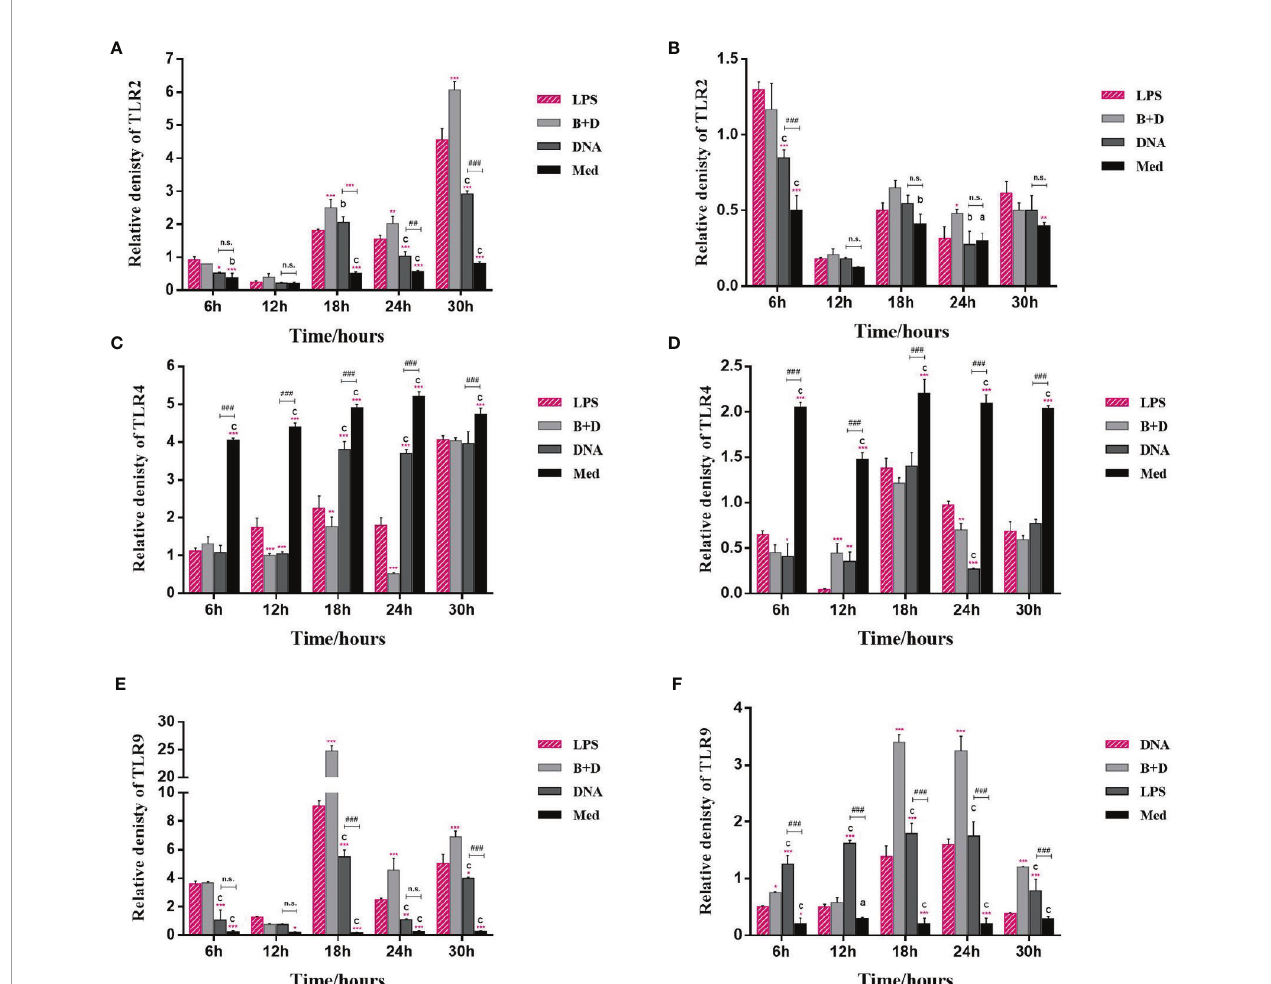
FIGURE 4 | mRNA expression of TLRs in macrophages. RAW264.7 cells and peritoneal macrophages were incubated with plasmid pCI – PoRV – VP6 (1 mg/mL) and bacterial ghosts (BGs) loaded with pCI – PoRV – VP6 (1000 bacteria/cell), respectively, at 37°C for 2 h. Total RNA was extracted at different times. The mRNA levels expression of TLRs were quanti fi ed using RT – qPCR. mRNA expression of (A) TLR2 in RAW264.7 cells, (B) TLR2 in peritoneal macrophages, (C) TLR4 in RAW264.7 cells, (D) TLR4 in peritoneal macrophages, (E) TLR9 in RAW264.7 cells, and (F) TLR9 in peritoneal macrophages. Values are expressed as the mean ± SD of four individual experiments. Signi fi cance of differences between the LPS, BG+DNA, DNA, and Med groups is represented as follows: *P < 0.05, **P < 0.01, ***P < 0.001. Letter indicates signi fi cant differences between BG+DNA, DNA, and Med groups: a P < 0.05, b P < 0.01, c P < 0.001. #Asterisk indicates a signi fi cant difference between DNA and Med groups: # P < 0.05, ## P < 0.01, ### P < 0.001. n.s., no signi fi